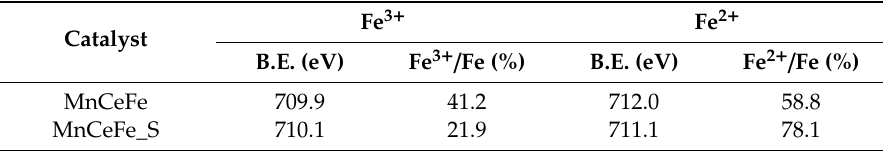
Table 8. Fe 2p XPS parameters of MnCeFe and